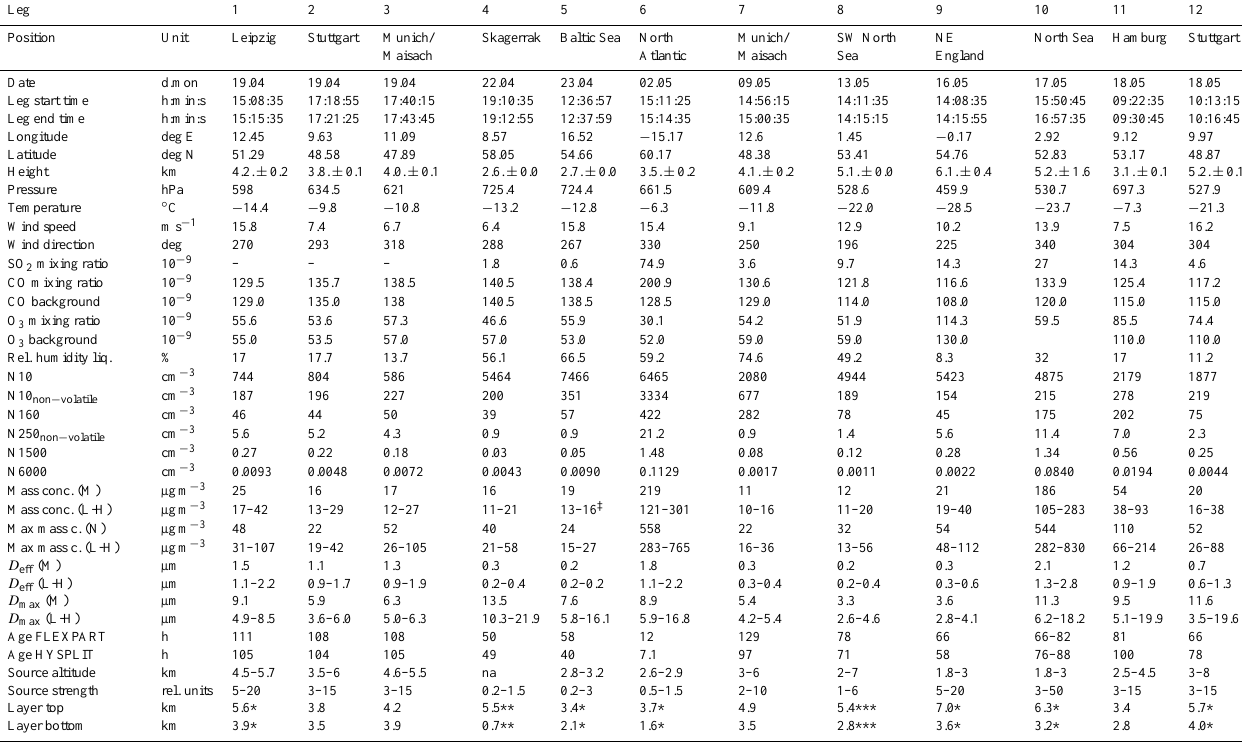
Table 3. Plume properties at selected flight